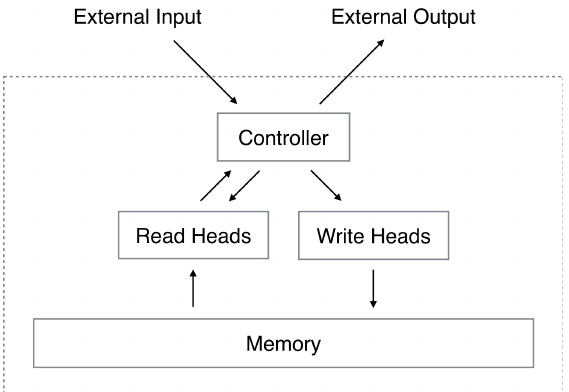
Figure 2. An architect of Neural Turing Machine consists of 4 parts: a controller, a write head, read heads and Memory (excerpt from